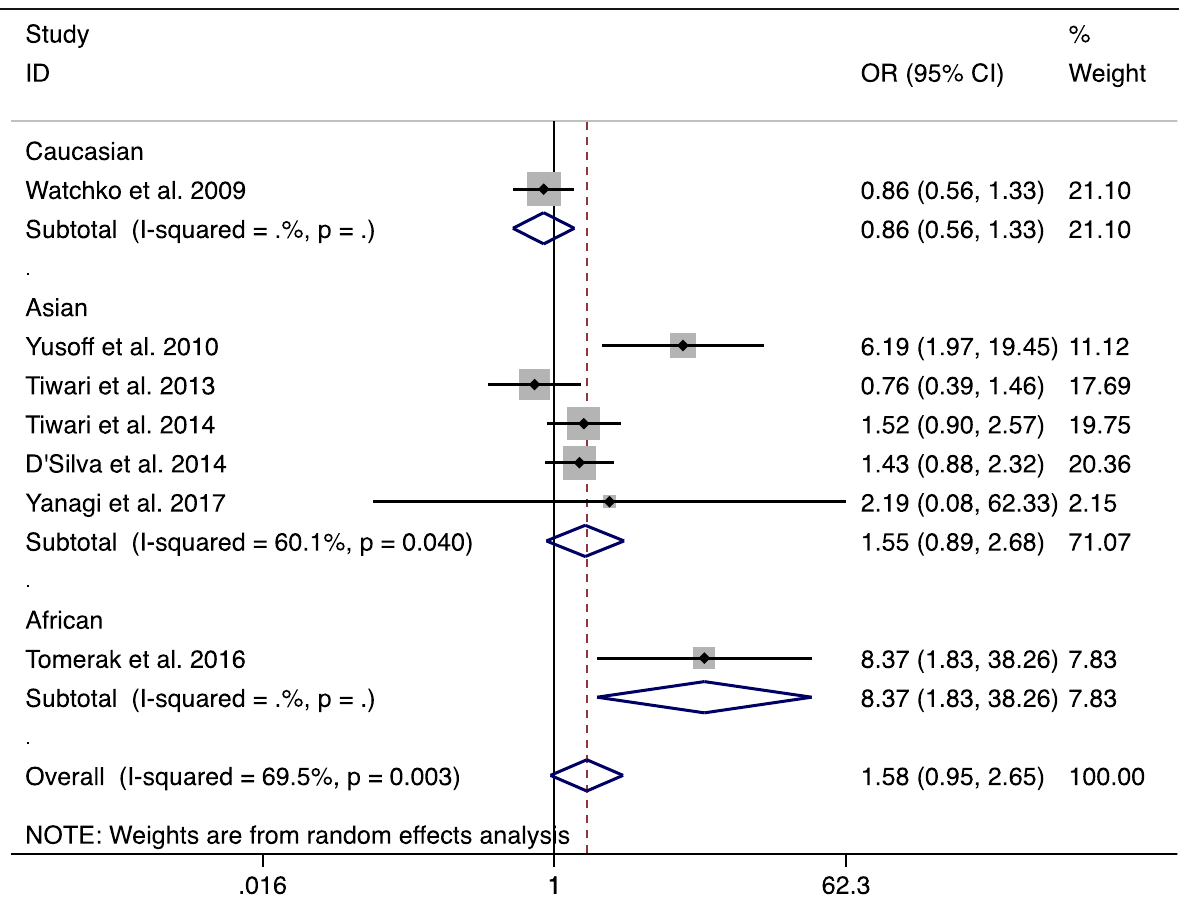
Fig. 4 Random-effects meta-analysis on NNH risk and c.-3279 T > G (rs4124874) polymorphism under GG vs GT + TT in African population (GG